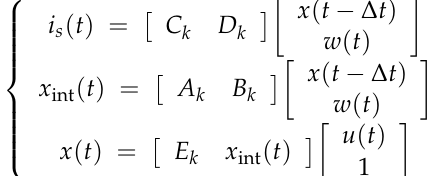
Figure 4. Variable detail sub-network SSN method task division and analysis. The node analysis method used in tasks 1 and 3 is strongly related to the model and process, and there are many types of expressions and complex data addressing; Task 2 is solved by the node elimination method, the data are dependent on the calculation process, and the control is complicated. These tasks are suitable for instructions control to achieve high resource utilization and complex calculations. From the observation in Figure 4, it can be found that tasks 1, 2, 3 and tasks 4, 5, 6 can be calculated in parallel, respectively, which means that the idle rate of computing units in the hybrid architecture is low. Therefore, the introduced AMA can be designed through tasks 4, 5 and 6.